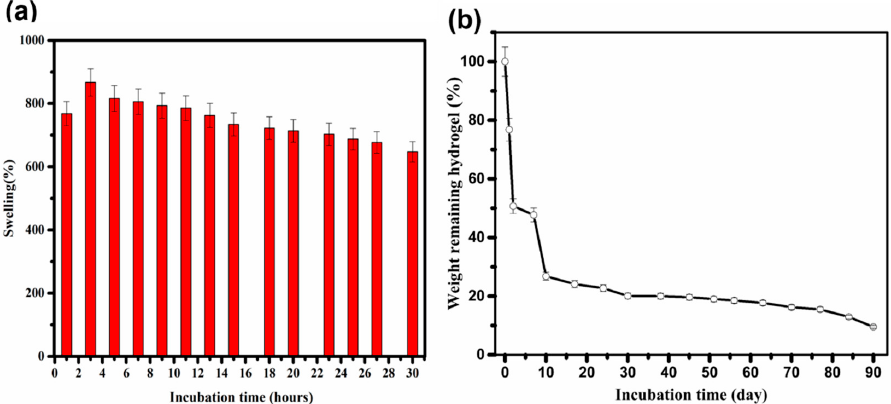
Figure 7. ( a ) Equilibrium swelling ratio (PBS, 37 °C, n = 4) and ( b ) in vitro degradation rate (culture medium, 37 °C, n = 3) of the thermosensitive and electroconductive hydrogel (75 mM AuNPs).